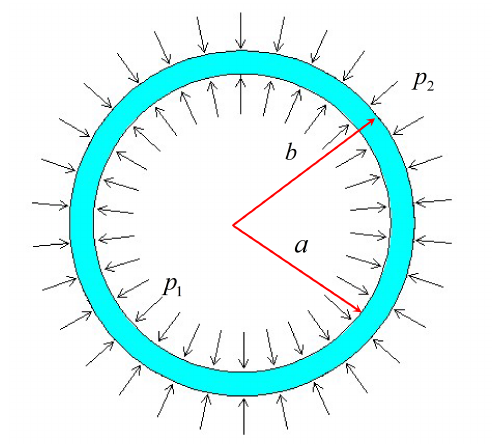
Figure 2: A thick walled cylinder under inner and outer presses